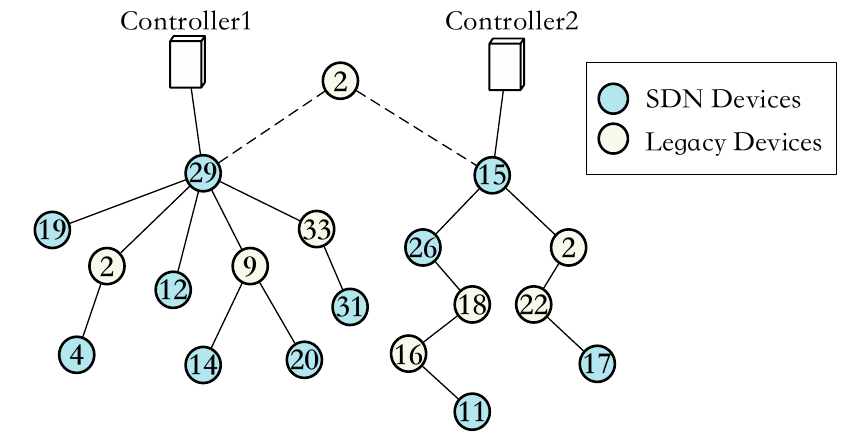
Figure 2. The control tree of Figure